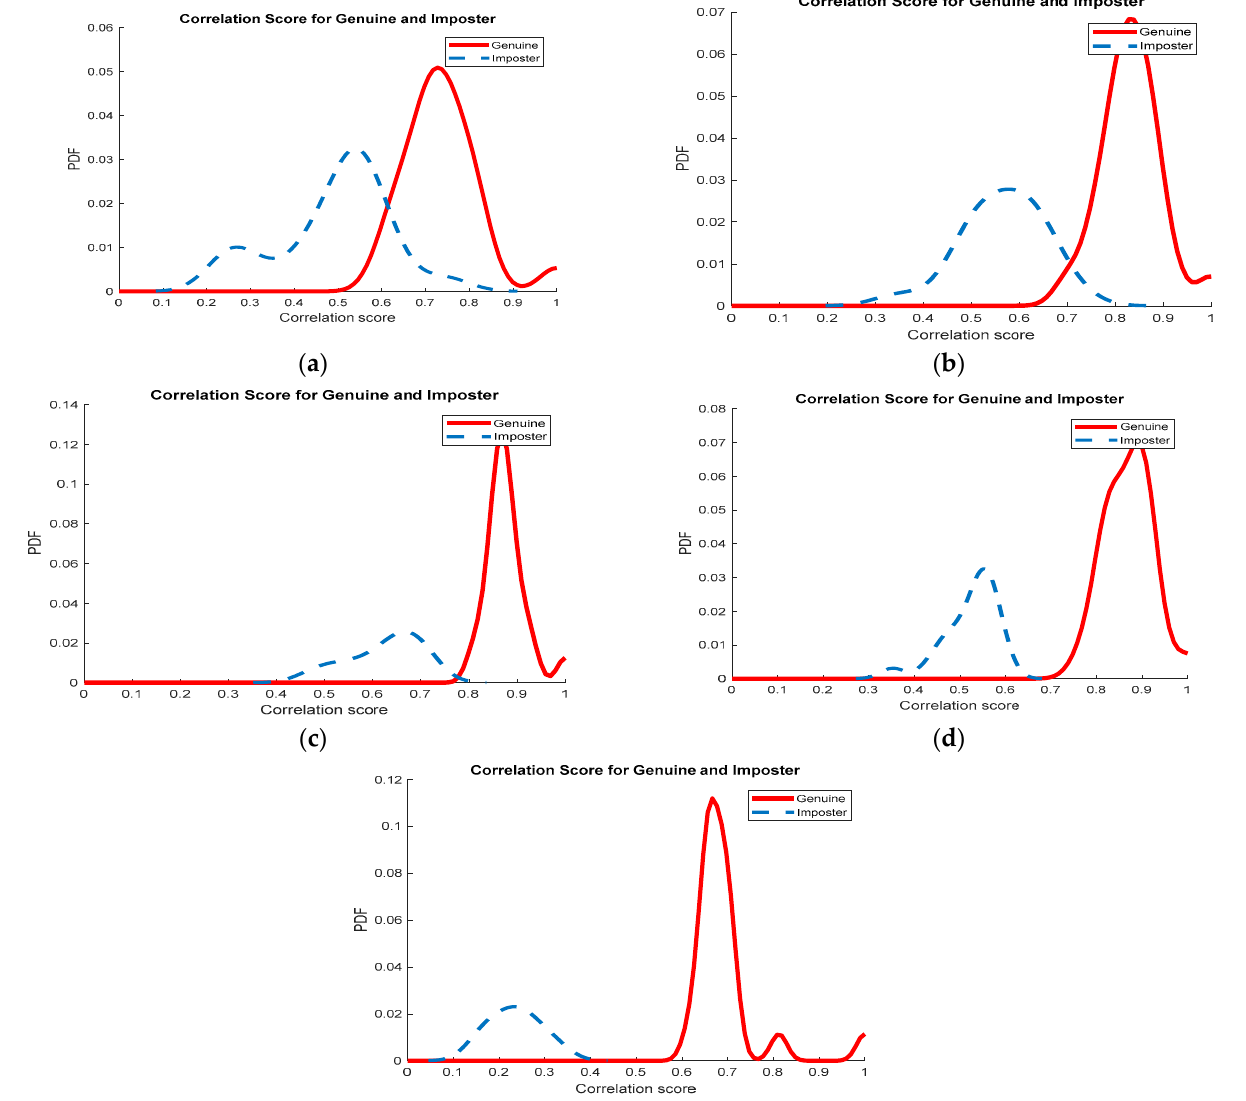
Figure 15. Impostor and genuine distributions using modified logistic map and an encrypted kernel with ( a ) circular encryption, ( b ) IWT encryption with similar keys for all sub-bands, ( c ) IWT encryption with different keys for all sub-bands, ( d ) DWT encryption with similar keys for all sub-bands, ( e ) DWT encryption with different keys for all sub-bands.